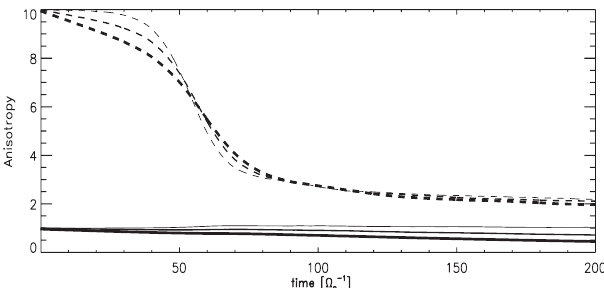
Fig. 4. The temporal evolution of the temperature anisotropy for protons (solid) and He ++ ions (dashes) obtained with the 1-D ex- panding box hybrid model for initially anisotropic He ++ temper- ature. The thin curves show the temporal evolution without ex- pansion ( (cid:15) = 0), the thicker curves are for (cid:15) = 10 − 3 , and the thick curves are for (cid:15) = 2 × 10 − 3